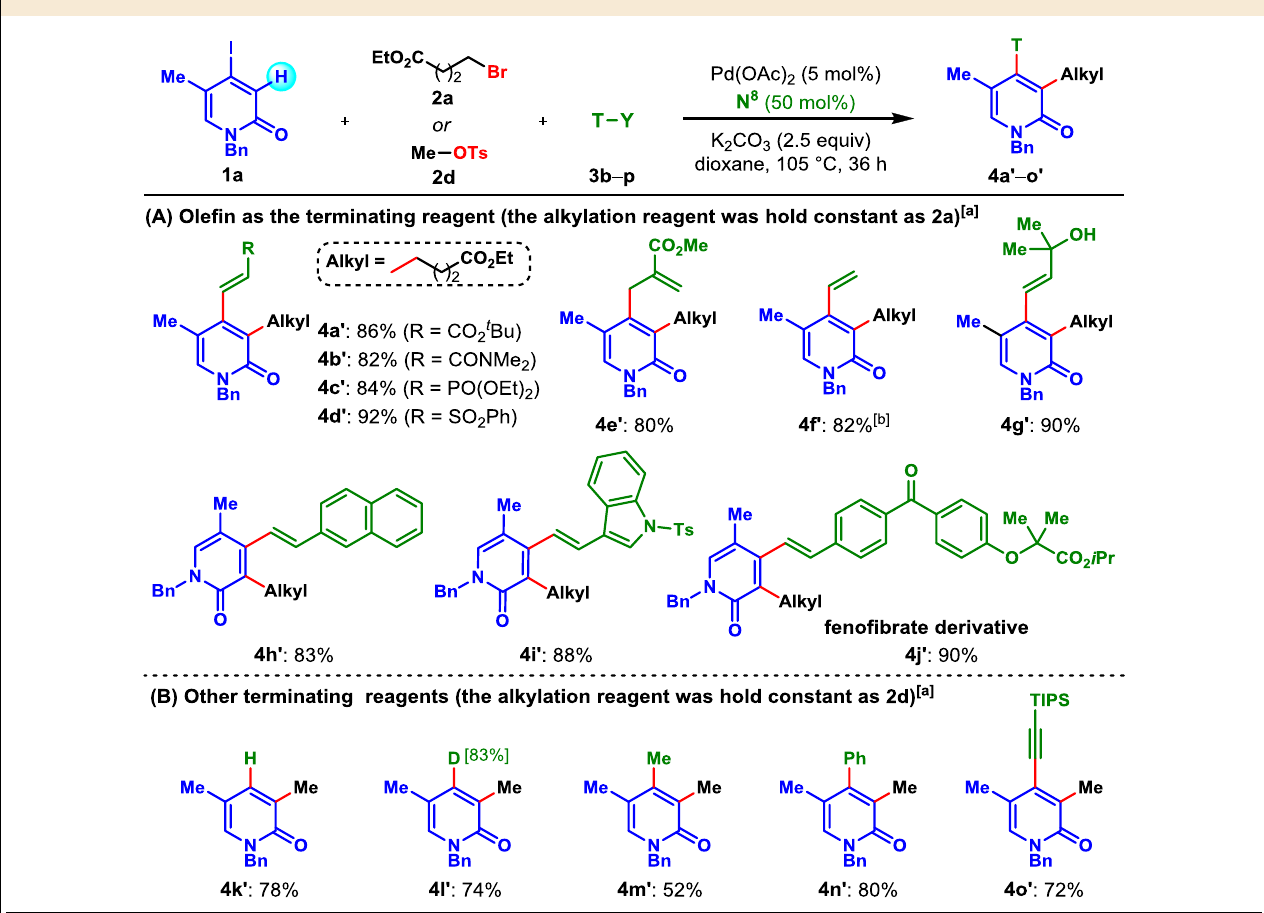
Table 3 Reaction scope with respect to the terminating